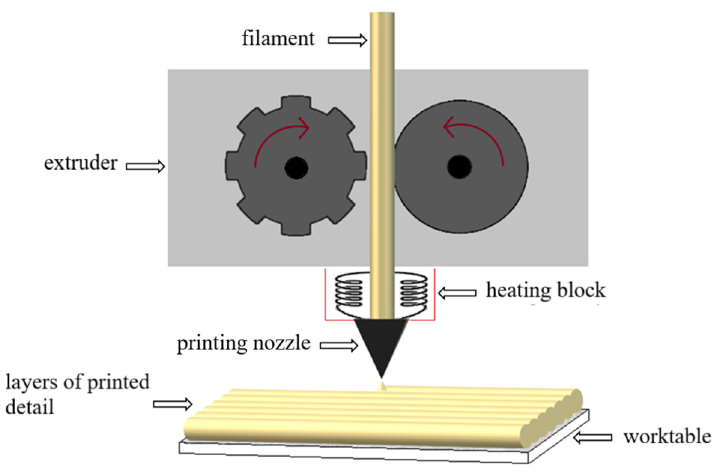
Figure 1. 3D printing process in MEM technology.